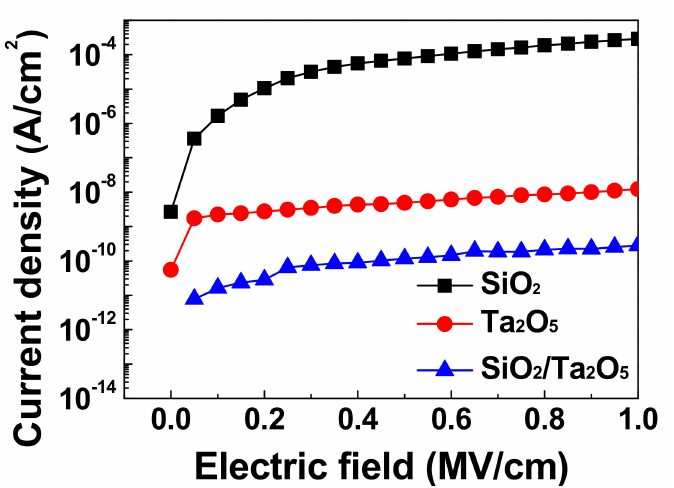
Figure 4. Leakage current densities of the SiO 2 (60 nm), Ta 2 O 5 (60 nm), and SiO 2 /Ta 2 O 5 (30 nm/30 nm) dielectric